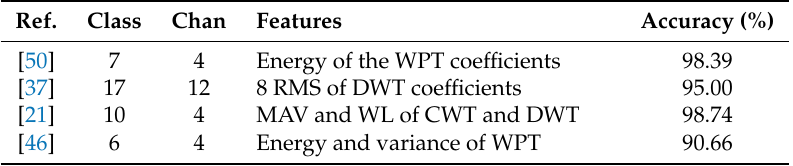
Table 6. EMG signals classification methods with time–frequency domain features. Ref.